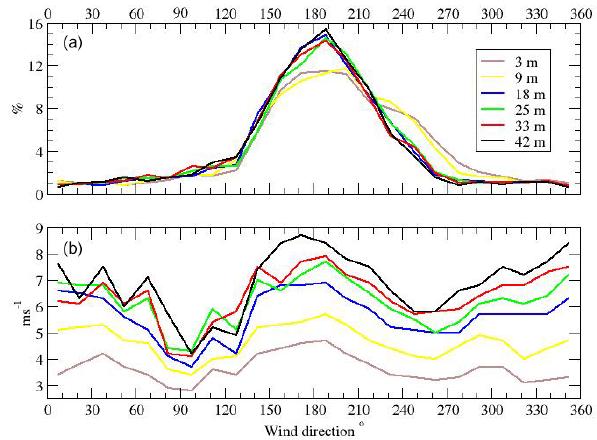
Figure 11. Probability distribution (a) and mean wind speed (b) according to wind